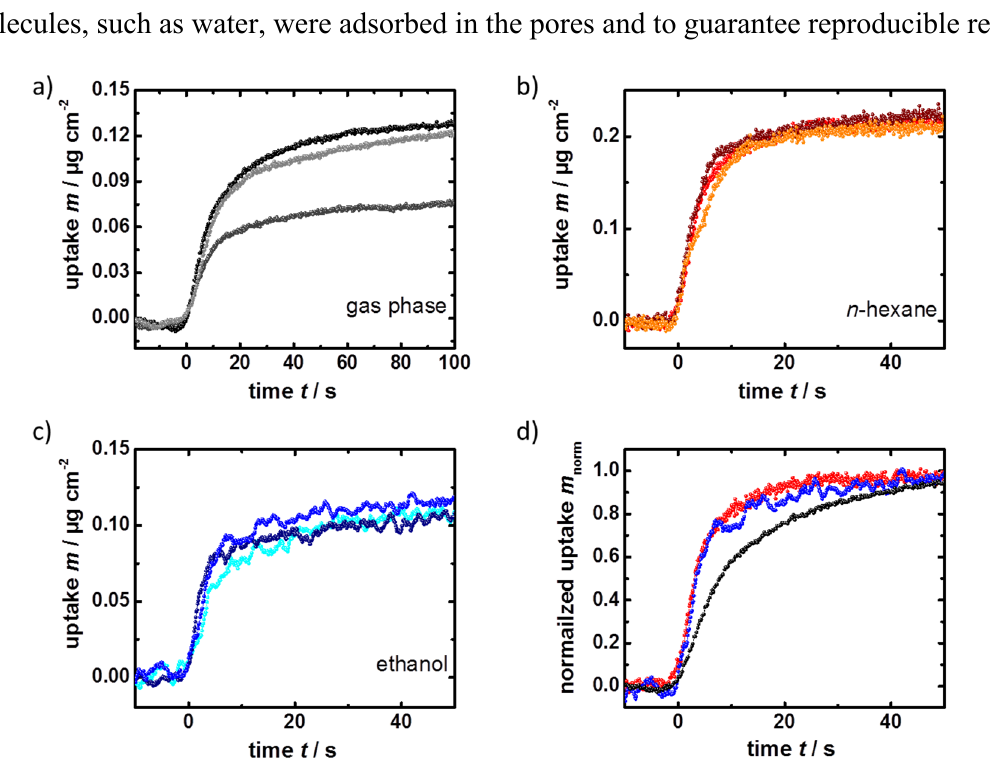
Figure 3. Ferrocene uptake by HKUST-1. The uptake curves of ferrocene vapor in